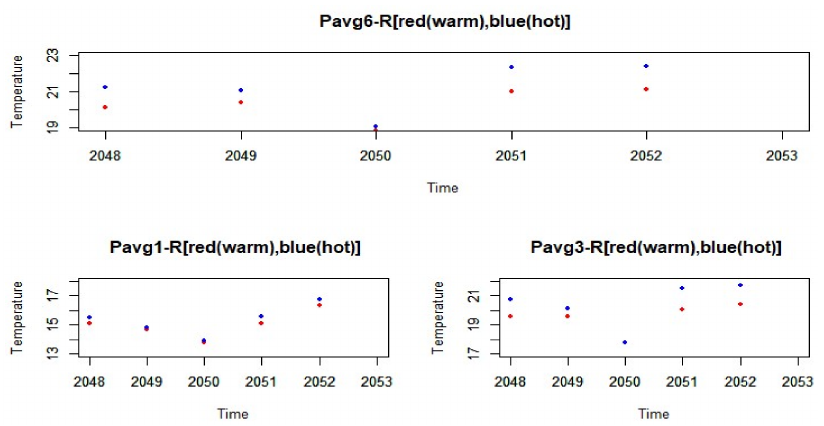
Figure 39. RCP 8.5 warm model (IPSL-CM5A-MR) and RCP 8.5 hot model (ACCESS1-0) predictions for the period 2048–2053 (recorded water level), temperature in ◦